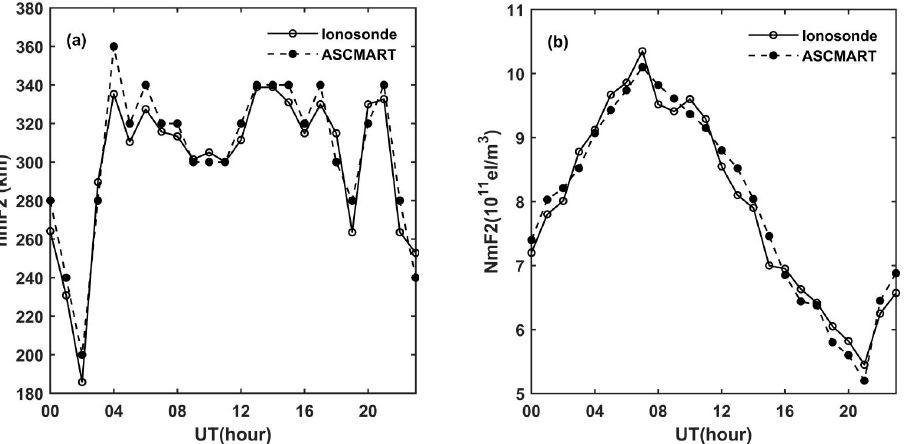
Figure 8. Comparisons of ( a ) the hmF2 and ( b ) NmF2 from the ASCMART with those obtained from the ionosonde located at Shaoyang on June 20, 2015. Table2. TomographicerrorstatisticsoftheMART,theSCMART,andtheASCMARTduringgeomagnetic quite